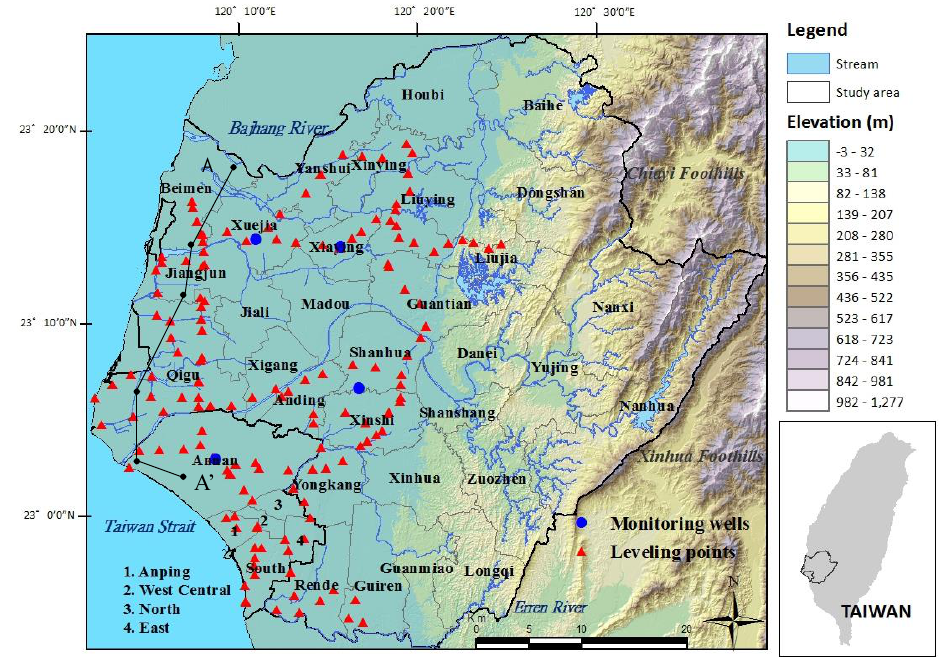
Figure 2. River system and geographic map with distribution of districts and monitoring points in Tainan City (From Wang et al., 2015).